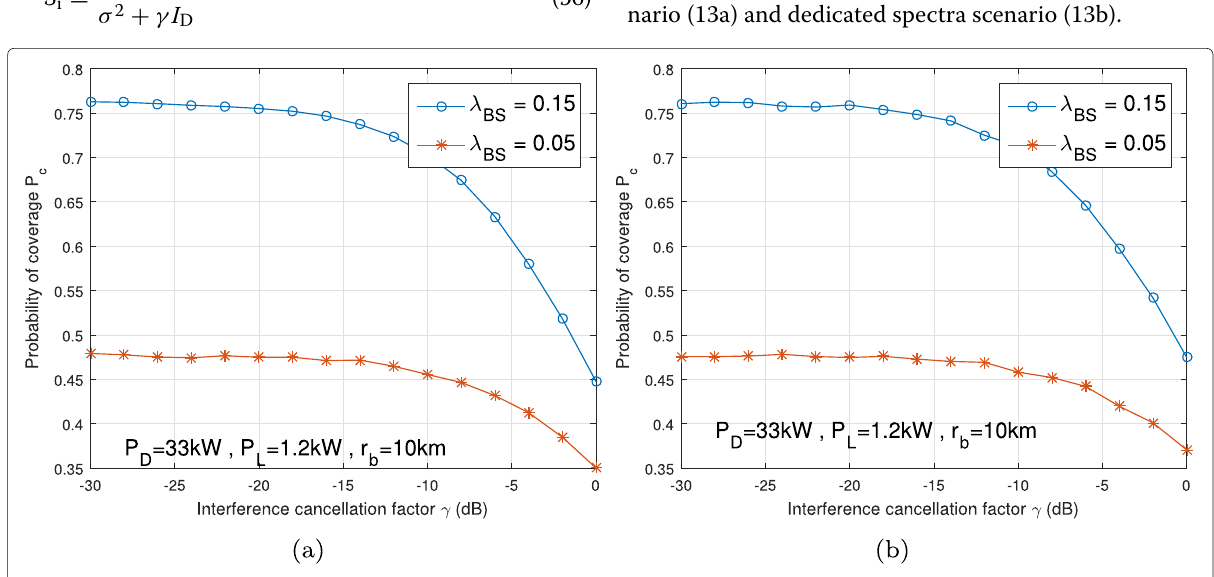
Fig. 13 Effect of interference cancellation factor γ on coverage and capacity for both scenarios. a Shared apectrum scenario b Dedicated spectra